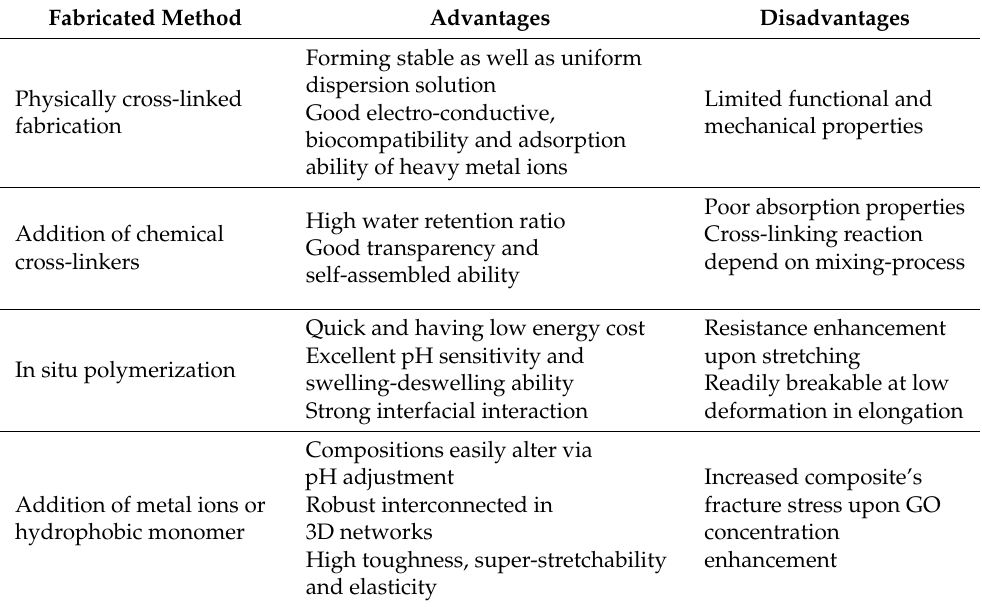
Table 1. Comparison of preparation techniques for graphene integrated